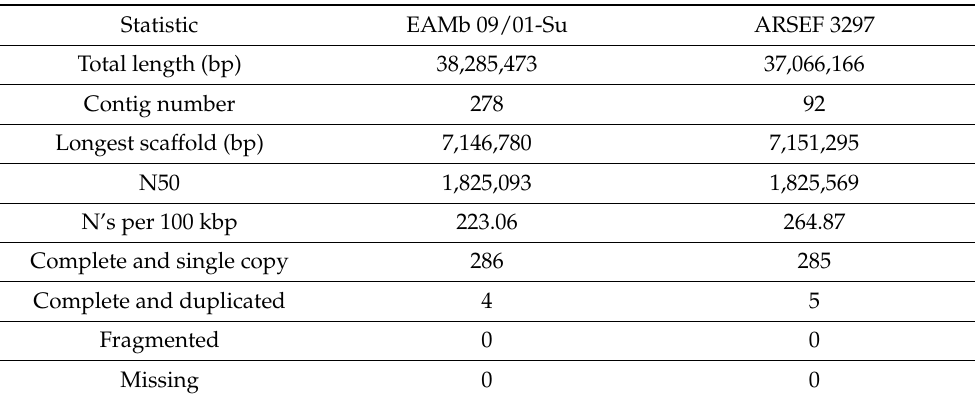
Table 2. Comparison of the assembly quality metrics for the reconstructed genome and the reference